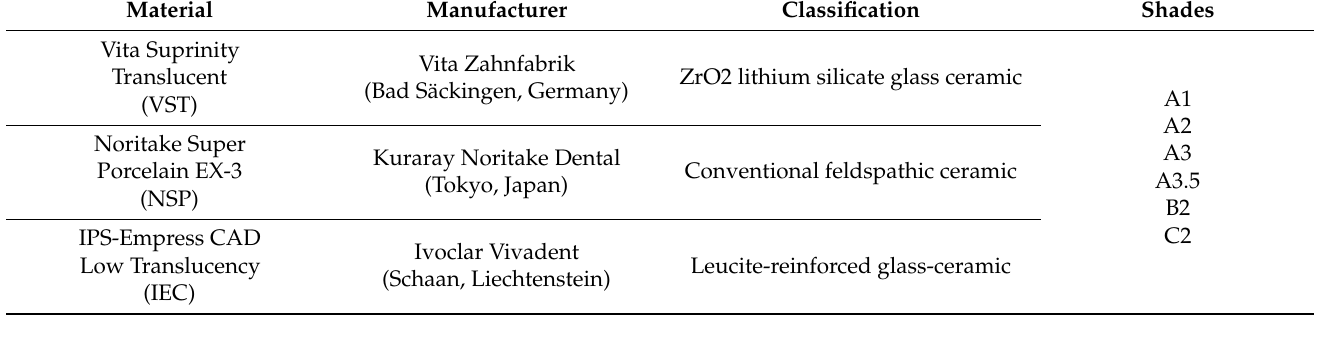
Table 1. Characteristics and information on the ceramic materials included in this study. All resin- based composite data were provided by manufacturers.